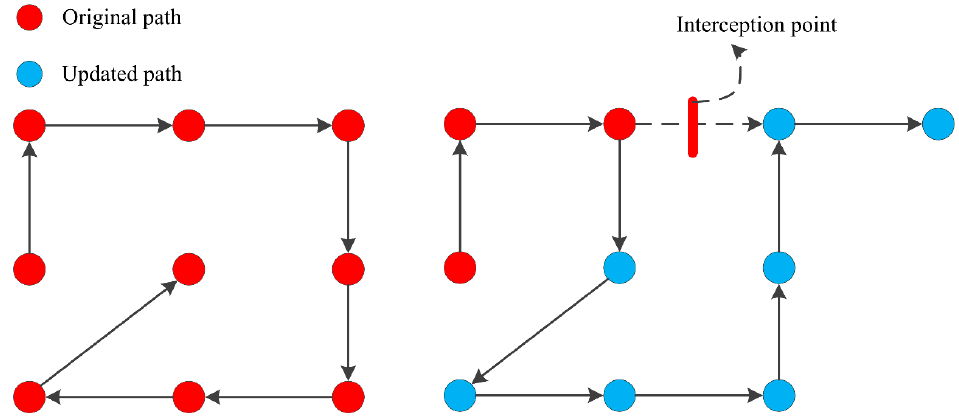
Figure 5. Schematic diagram of the path backtracking strategy.